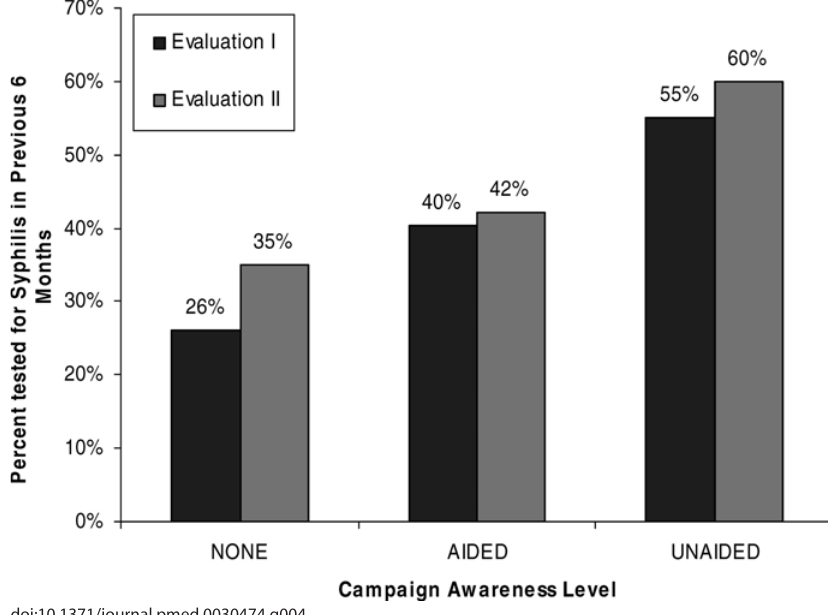
Figure 4. Syphilis Testing by Healthy Penis Campaign Awareness Level and Evaluation